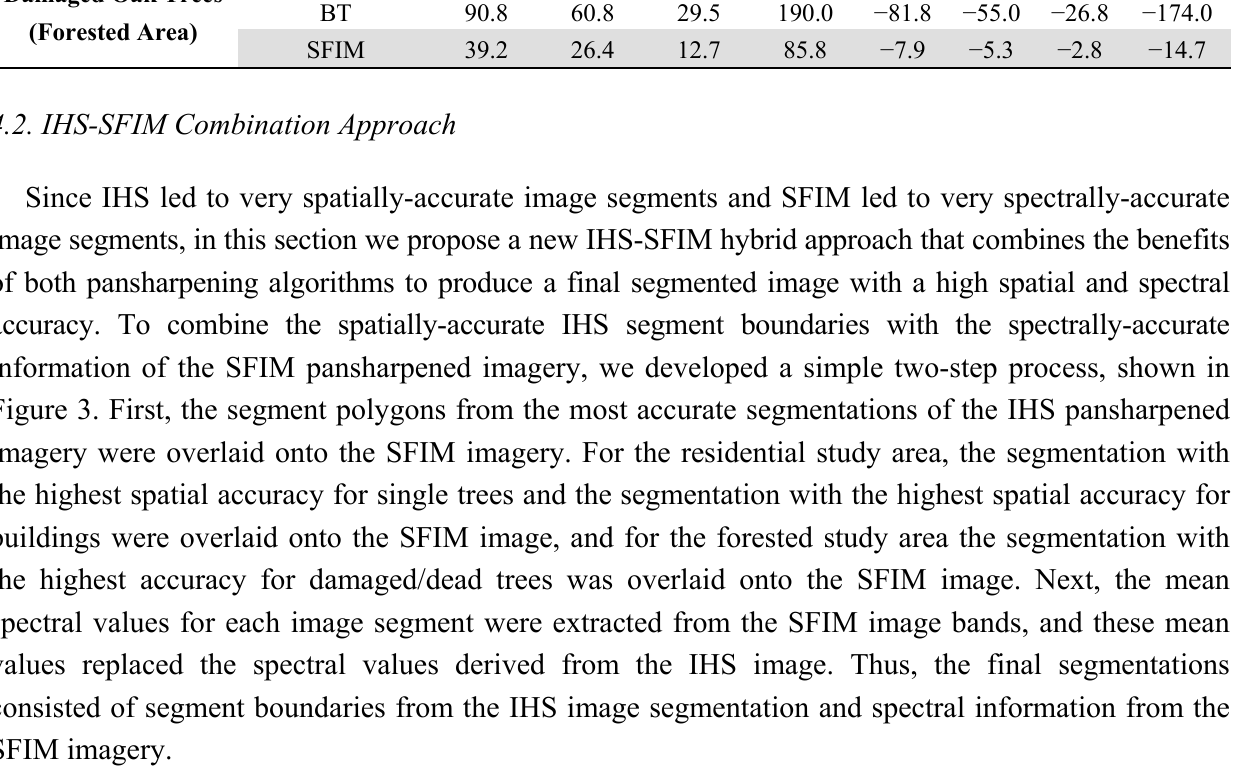
Figure 3. First, the segment polygons from the most accurate segmentations of the IHS pansharpened imagery were overlaid onto the SFIM imagery. For the residential study area, the segmentation with the highest spatial accuracy for single trees and the segmentation with the highest spatial accuracy for buildings were overlaid onto the SFIM image, and for the forested study area the segmentation with the highest accuracy for damaged/dead trees was overlaid onto the SFIM image. Next, the mean spectral values for each image segment were extracted from the SFIM image bands, and these mean values replaced the spectral values derived from the IHS image. Thus, the final segmentations consisted of segment boundaries from the IHS image segmentation and spectral information from the SFIM